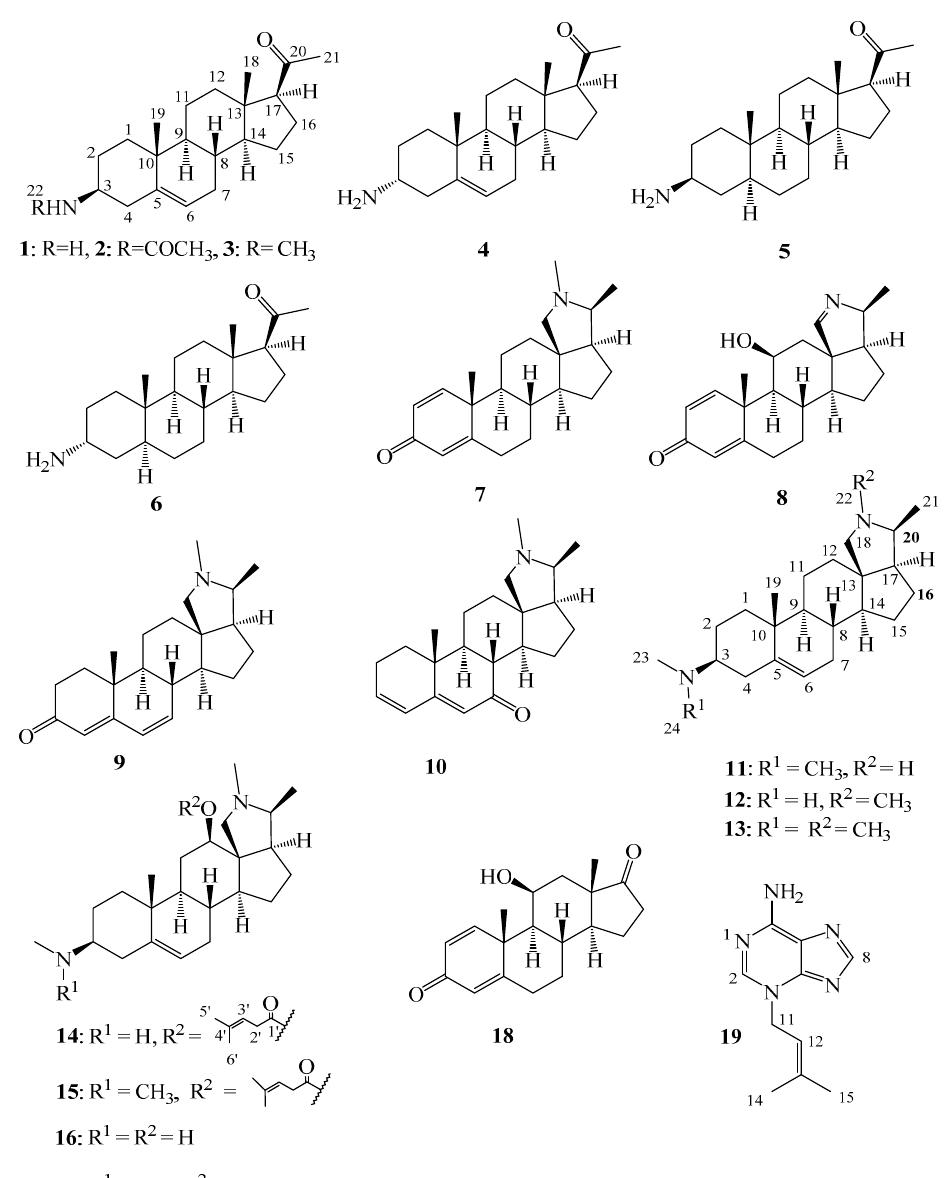
Figure 1. Compounds isolated from the leaves ( 1 – 6 , 19 ) and stem bark ( 7 – 18 ) of Holarrhena africana